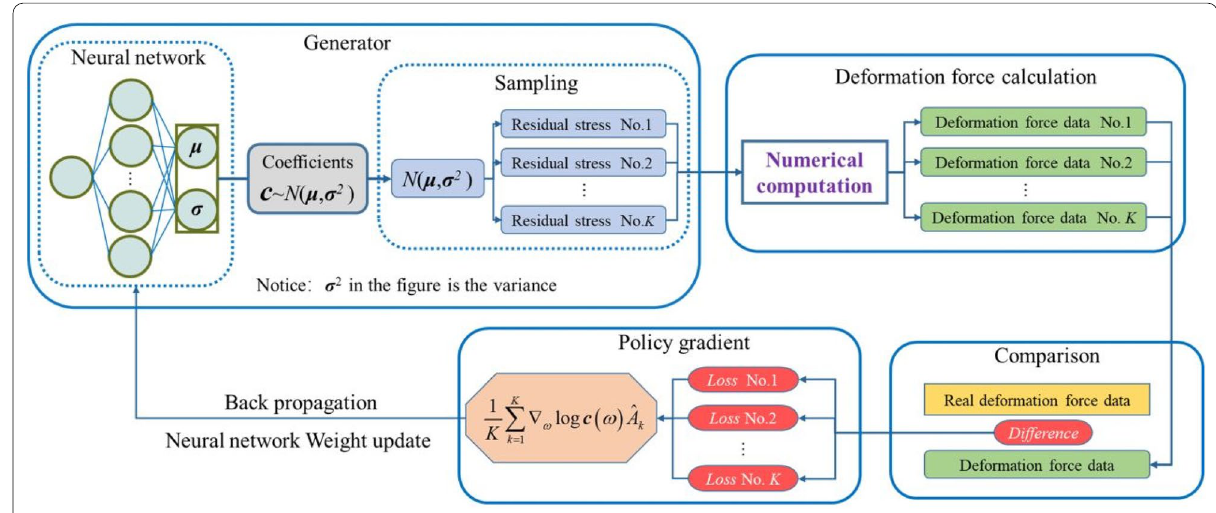
Figure 3 Flow chart of initial residual stress field inference based on strategy gradient